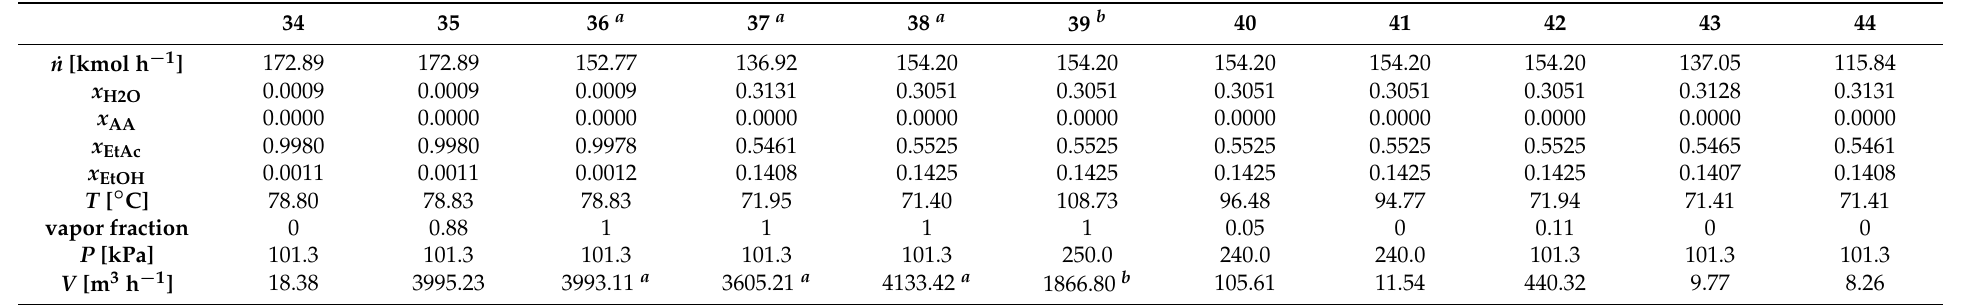
Table A2. Material balance of designed conventional process set-up with an MVRHP (Figure 4): heat pump subsystem.